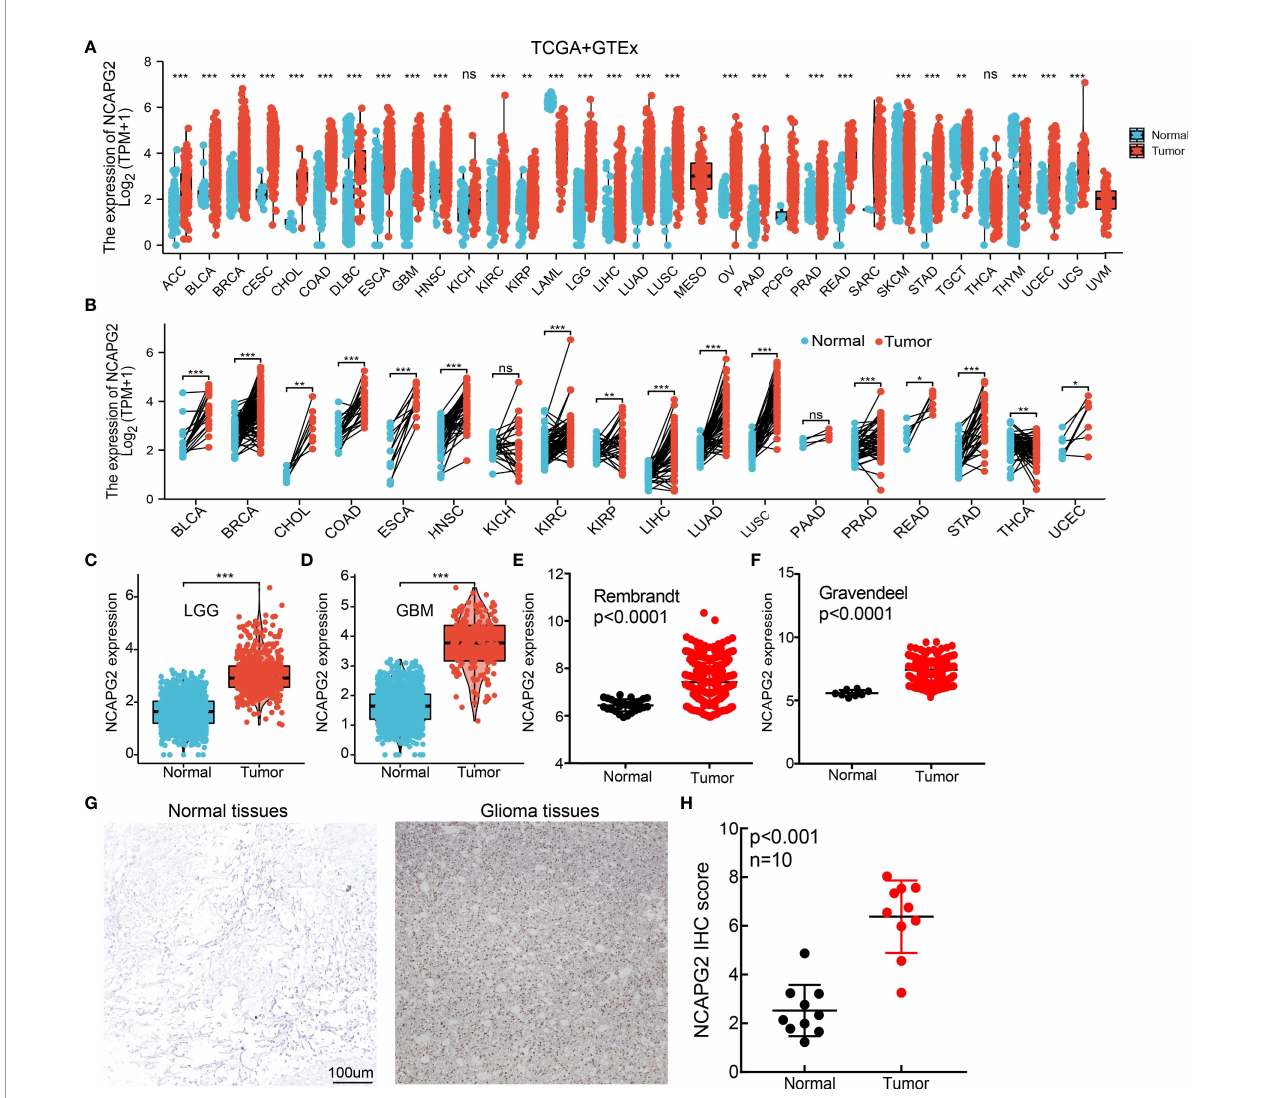
FIGURE 1 | NCAPG2 is highly expressed in LGG. (A, B) NCAPG2 expression levels in different tumor tissues and adjacent normal tissues from TCGA and GTEx databases. (C, D) The expression of NCAPG2 in LGG and GBM examined by TCGA and GTEx databases. (E, F) The expression of NCAPG2 in LGG examine by Rembrandt and Gravendeel dataset. (G, H) The protein level of NCAPG2 in Normal and glioma tissues based on IHC assay results. P > 0.05 (NS), P < 0.05 (*), P < 0.01 (**) and P < 0.001